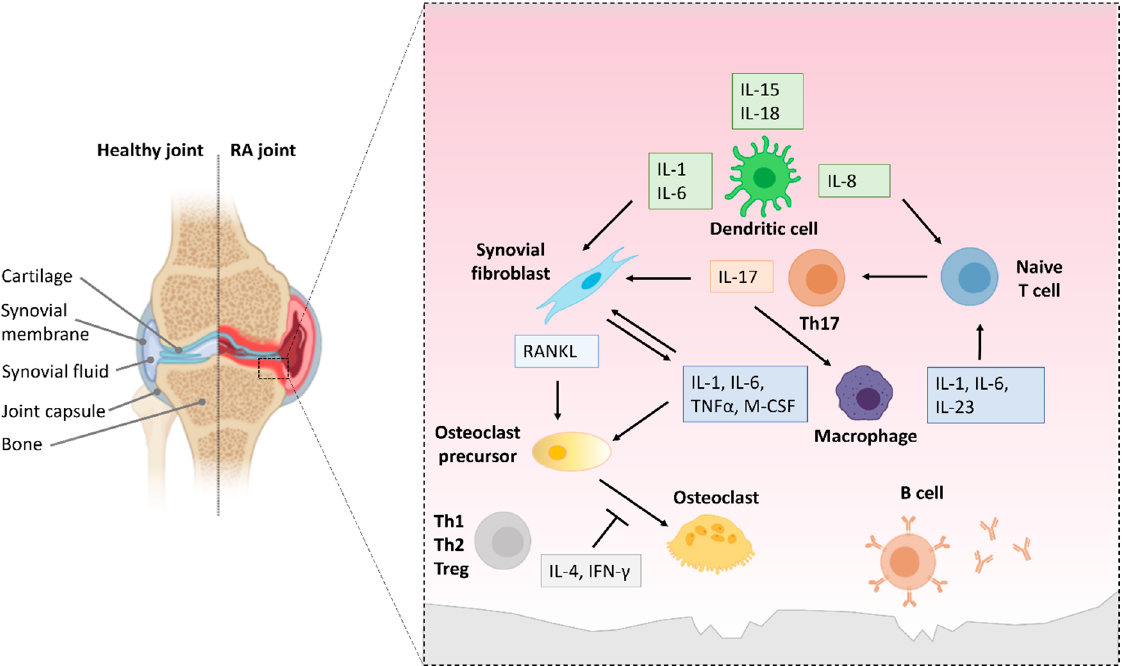
Figure 6. The role of NF- κ B activity in the pathology of RA. This figure summarizes experimental findings reviewed in [227,230,231].